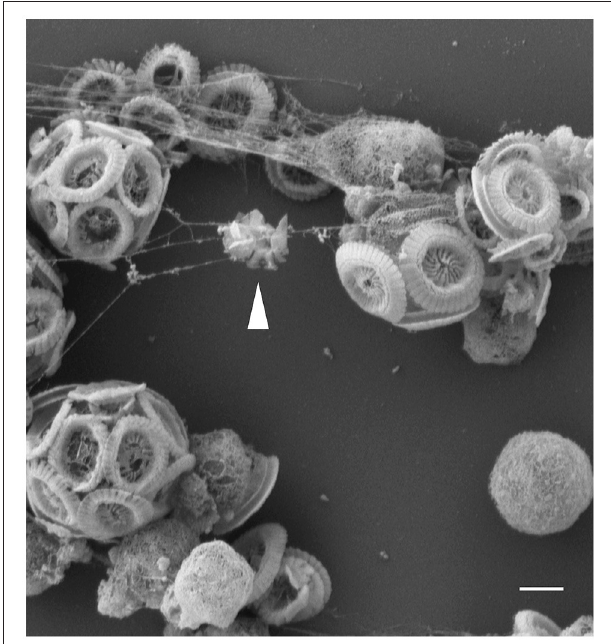
FIGURE 1 | Threads of extracellular matrix connect algal cells. Scanning Electron Microscopy (SEM) image of E. huxleyi cells with threads attaching individual calcified and naked cells. Coccoliths debris seen trapped in the threads (see arrow head), suggestive of the adhesive nature of the filaments. Scale bar corresponds to 1 µ m. See Data Sheet 1 for Materials and Methods.